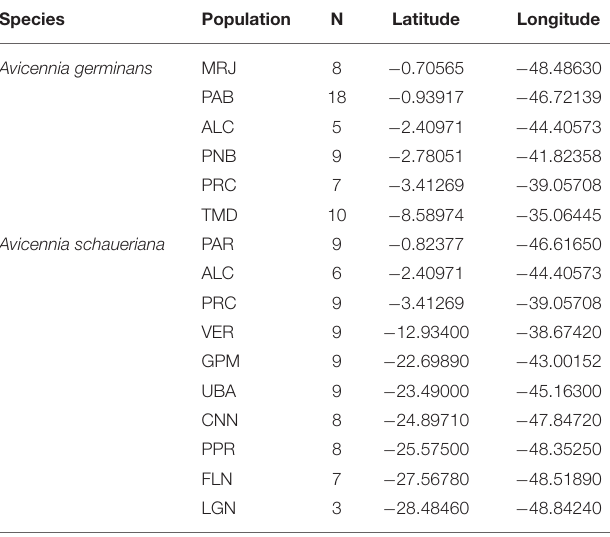
TABLE 1 | Population name codes, geographic coordinates, and sample sizes of Avicennia germinans and Avicennia schaueriana individuals sampled for the genomic environmental association